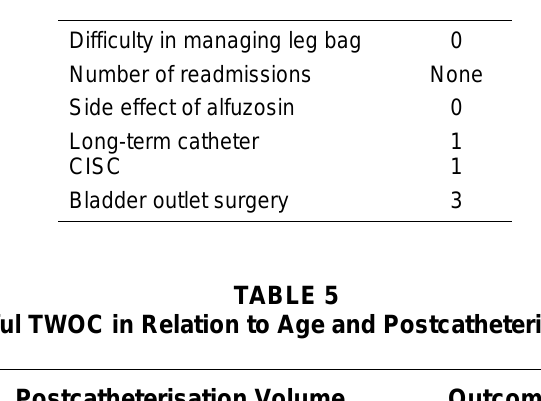
Complications and Outcomes of Unsuccessful TWOC